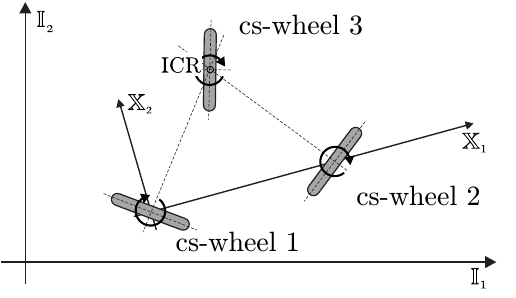
Figure 5. An example for a singularity of type C for a robot with three cs-wheels that are not coaligned: the ICR, defined by wheels one and two, coincides with the contact point of wheel three.